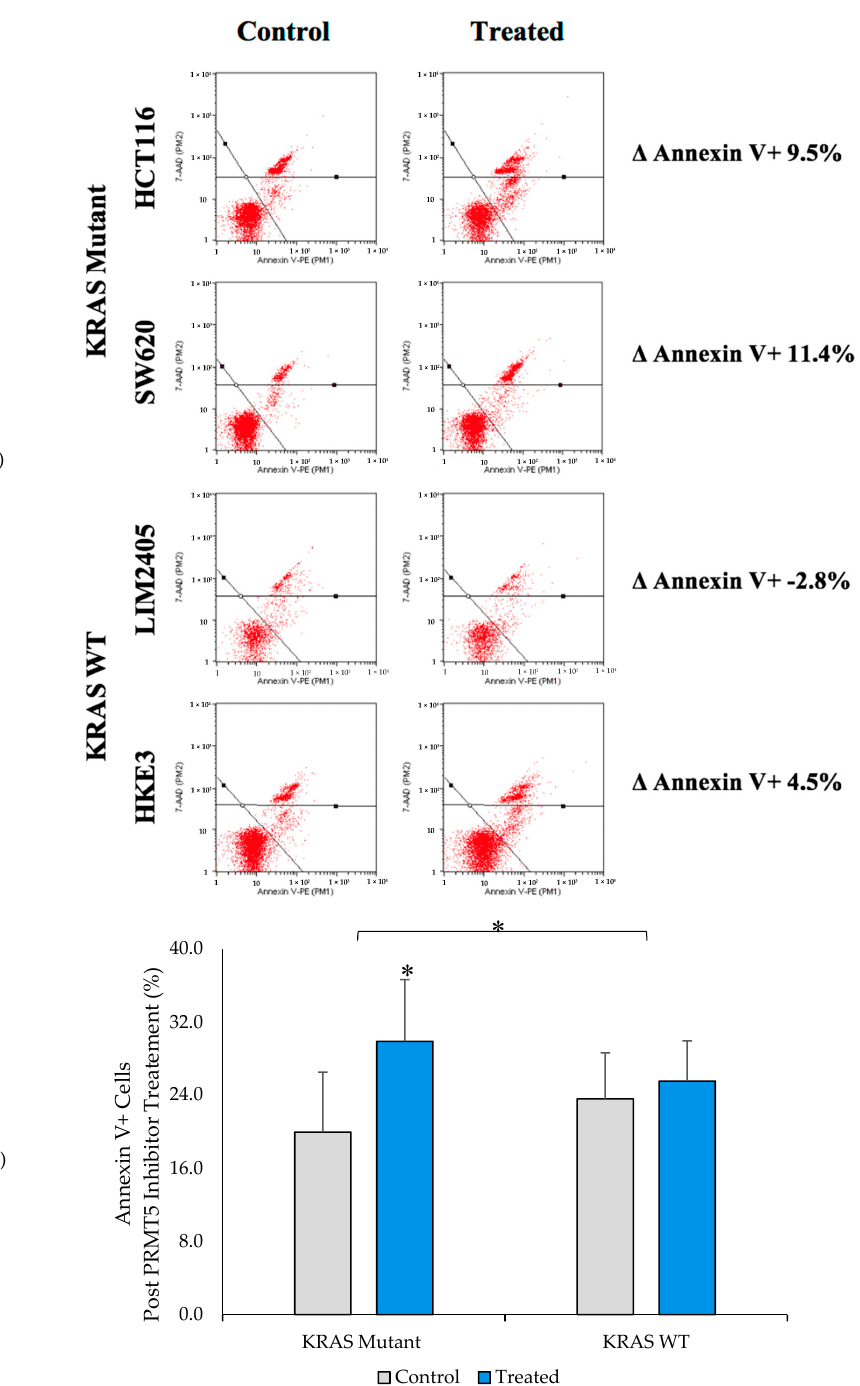
Figure 5. PRMT5 inhibitor treatment is shown to affect apoptosis in the KRAS mutant CRC cells by Annexin V analysis. ( a ) Flow cytometry dot plots displaying Annexin V assay results; ( b ) Quantified Annexin V assay results displaying that PRMT5 inhibitor treatment shows an 8.0% ( p < 0.05) greater increase in apoptosis after 60 h of 10 µ M PRMT5 inhibitor treatment in the KRAS mutant CRC cells when compared to the KRAS WT CRC cells. Data are expressed as means + SD from three independent experiments using four CRC cell lines (2 KRAS mutant, 2 KRAS WT). Data for the individual cell lines can be seen in Figures S2 and S3. * represents p <